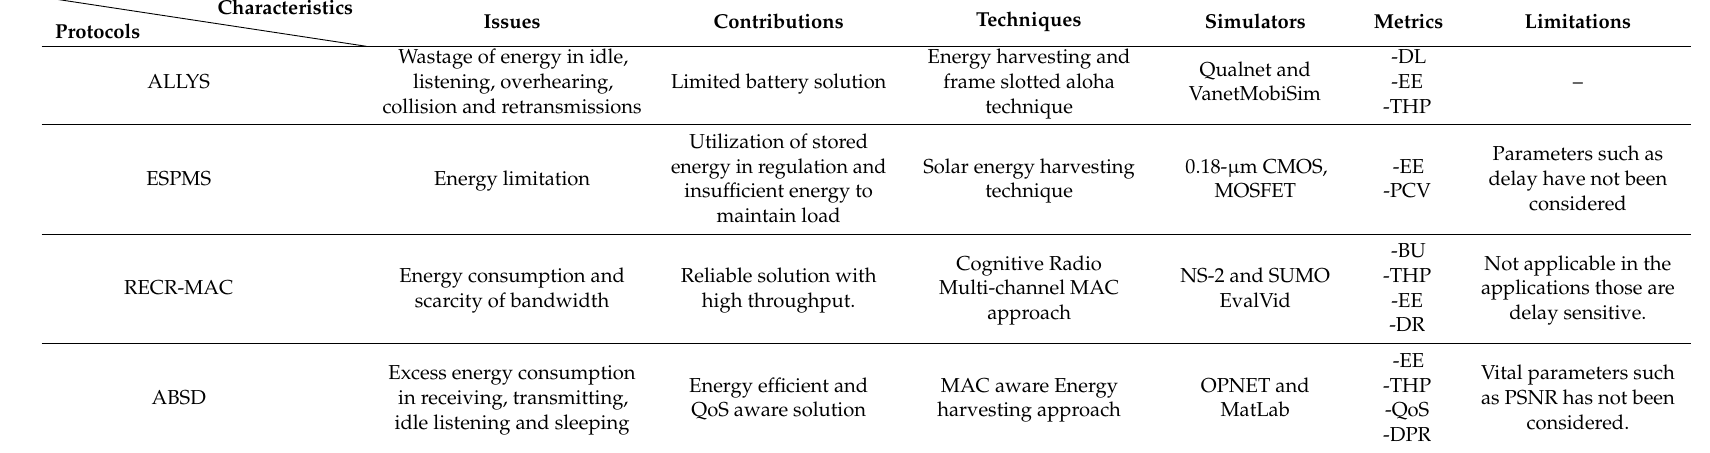
Table 6. Summary of energy efficient techniques at local processing and storage layer.